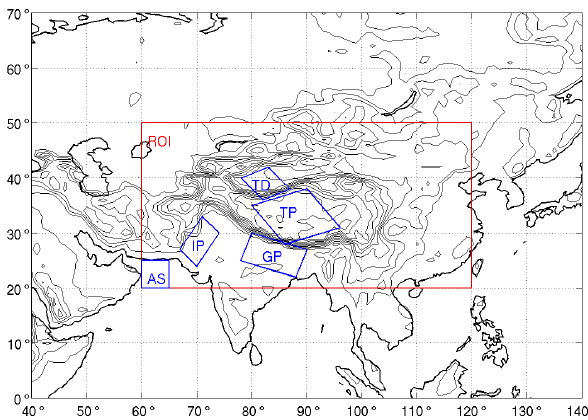
Fig. 1. Map of the Region of Interest (ROI) in red and the differ- ent subregions in blue: Arabian Sea (AS), Ganges Plains (GP), In- dus Plains (IP), Taklamakan Desert (TD), and Tibetan Plateau (TP). Thick black lines indicate the coast, thin black lines represent levels of equal altitude (each